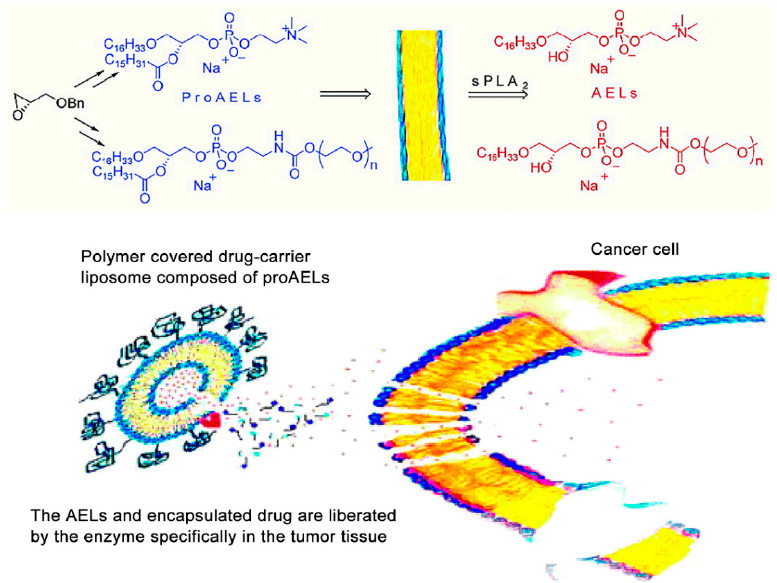
Figure 3. Chemical structures of two different pro-antitumor ether lipids (proAELs) that have been synthesized and investigated with respect to their physical properties and ability to constitute a novel liposome-based drug-delivery system. Secretory phospholipase A2 (sPLA2) hydrolyzes the liposome membrane, thereby releasing both activated antitumor ether lipids (AELs) and the encapsulated drug. The AELs are cytotoxic to cancer cells. Furthermore, synergistically with the generated fatty acids, they function as permeability enhancers that promote drug uptake by the cancer cells. Reproduced from ref. [126] with permission from the American Chemical Society.